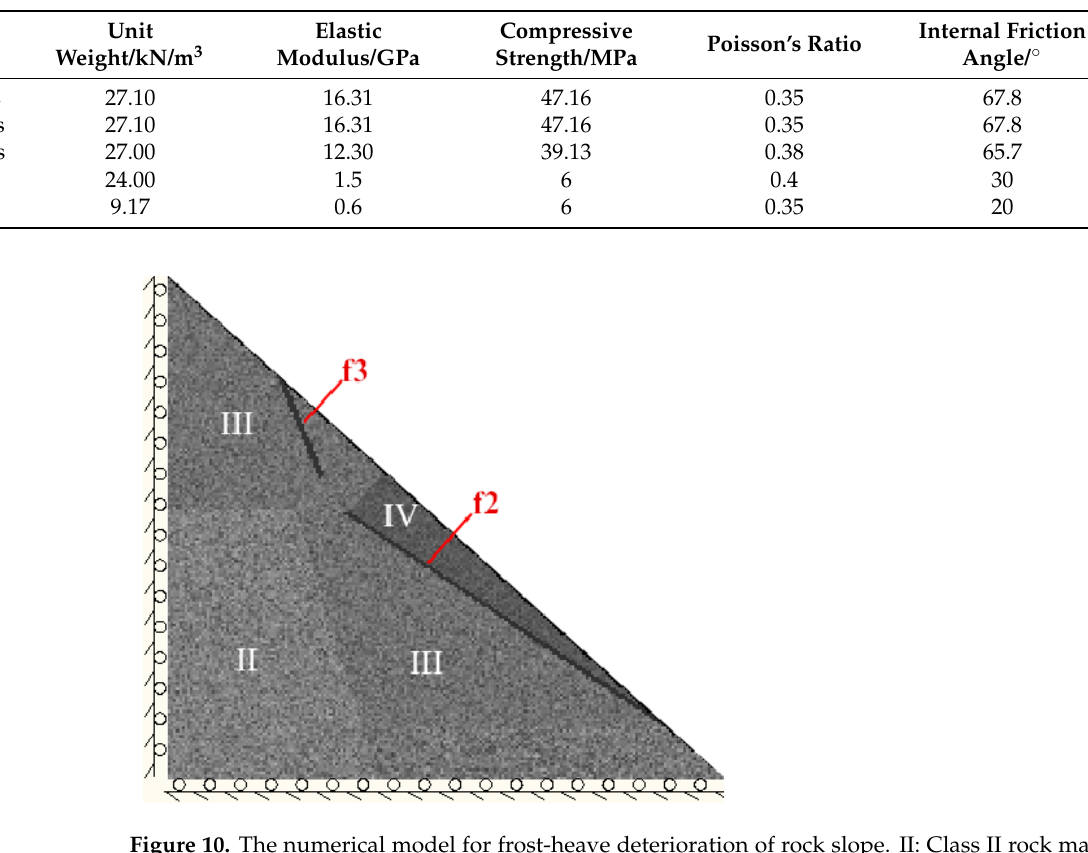
Table 4. The physical and mechanical parameters of the numerical model.